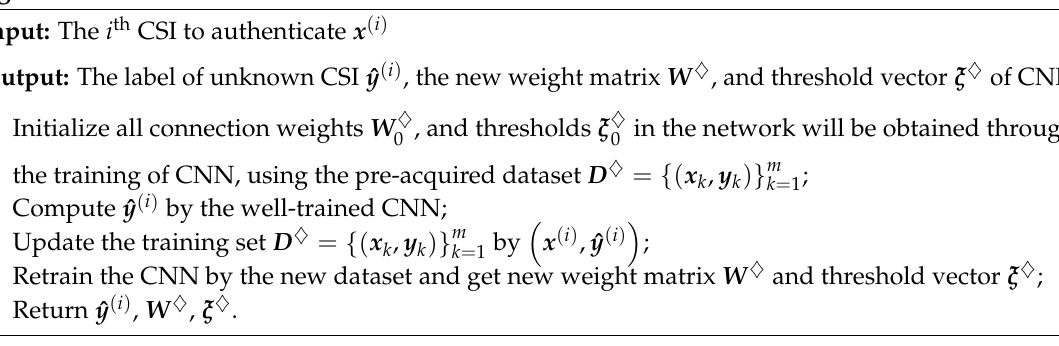
Algorithm 2 CNN-based sensor nodes’